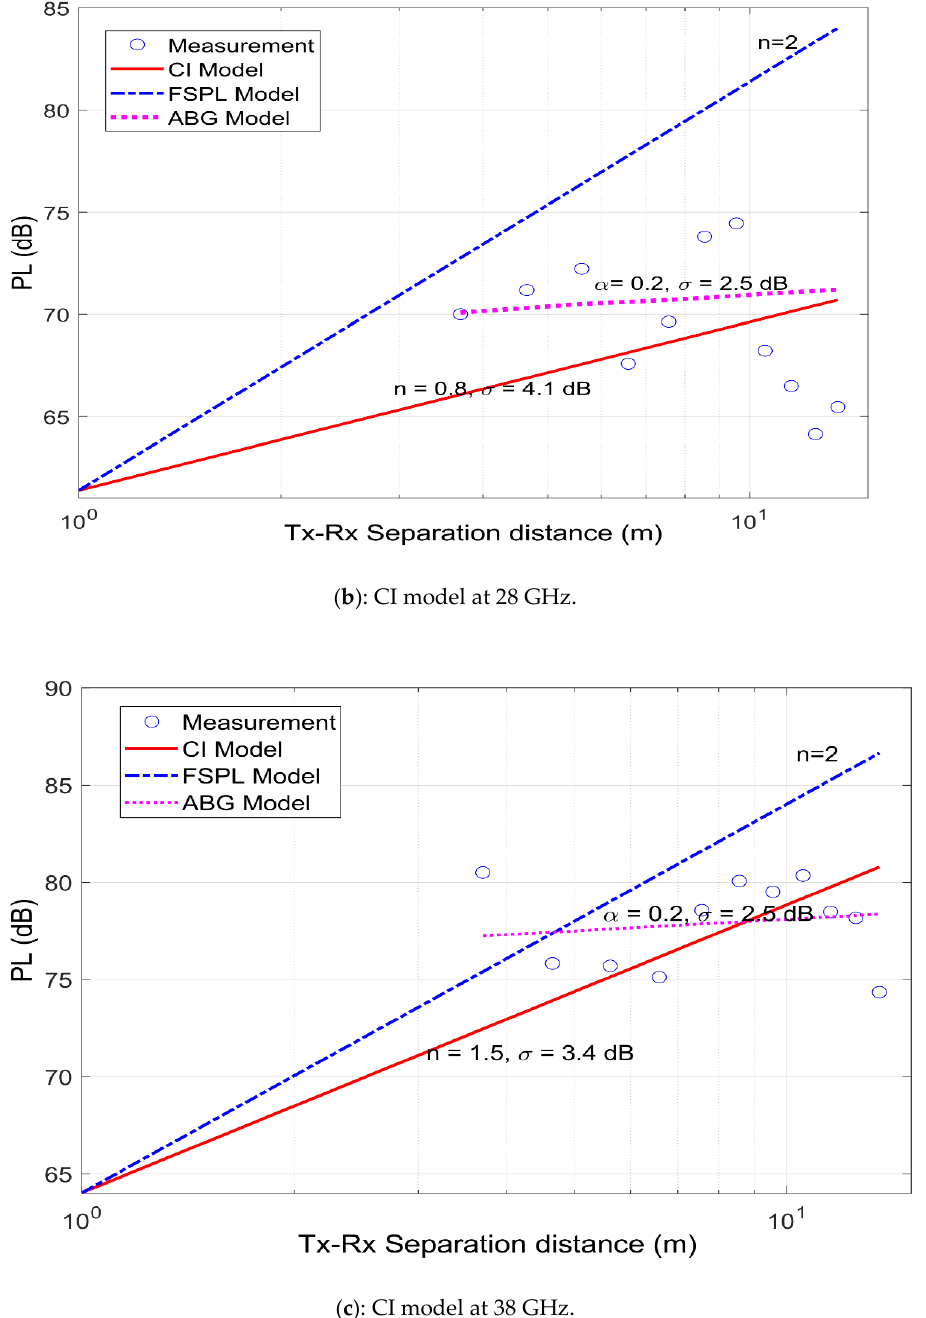
Figure 3. Path loss versus Tx–Rx separation distance using horn-omnidirectional antennas for the soft non-line-of-sight (NLOS) environment.